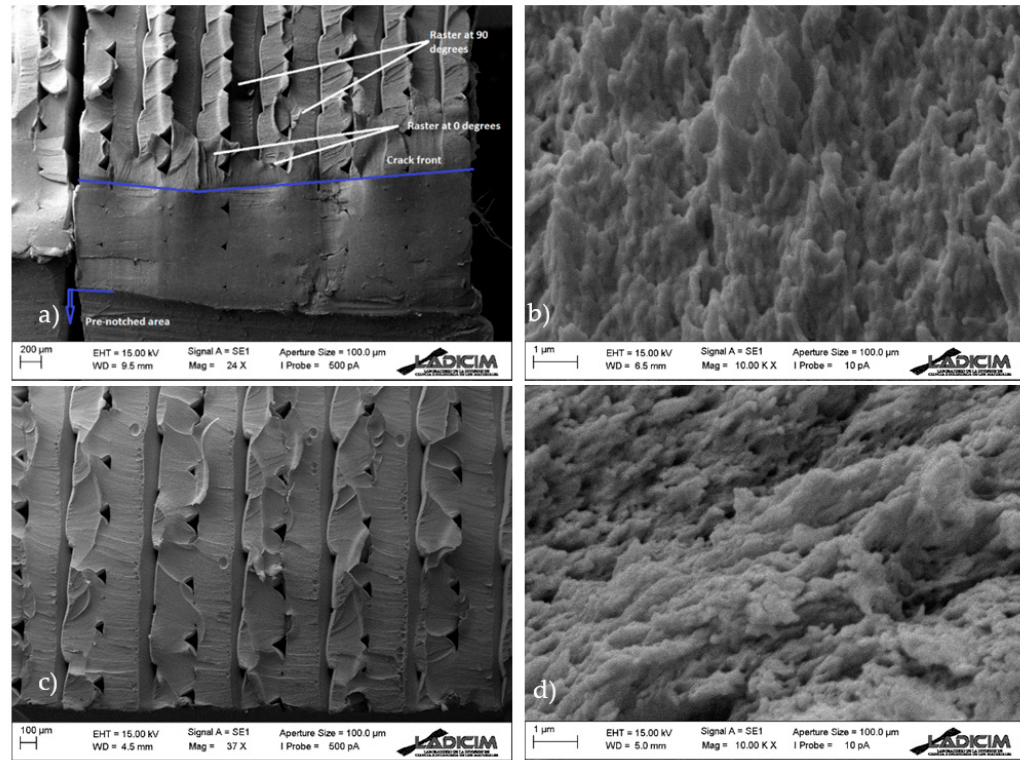
Figure 7. Scanning electron microscopy (SEM) images obtained from 0 / 90 samples; ( a ) overall view of cracked specimen; ( b ) detail of fracture micromechanisms at the crack front; ( c ) overall view of specimen with a notch radius of 2 mm; ( d ) detail of fracture micromechanisms at the defect front.